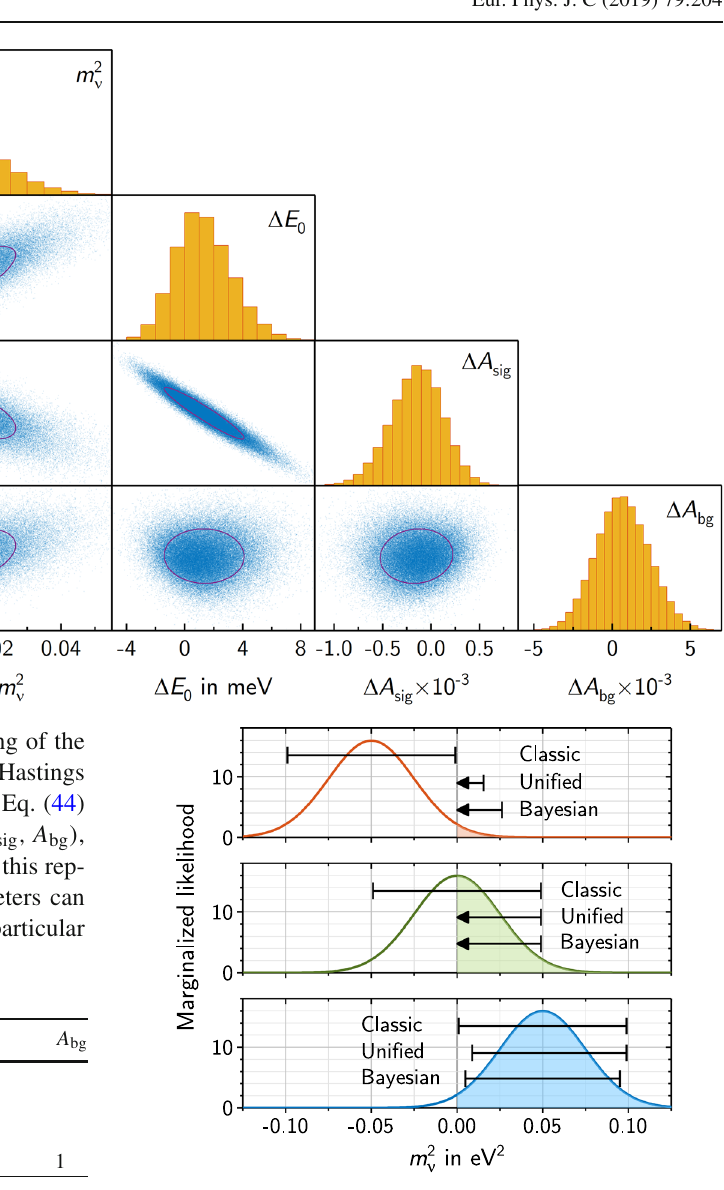
Fig. 17 Marginalized likelihood functions for various estimates of m 2 ν from representative Asimov data sets(In a representative Asimov data set [61] statistical fluctuations are suppressed, effectively replacing the number of (generated) observed events N obs by their expectation value jk (cid:22) (cid:22) N pre m 2 ν = − 0 . 05 eV 2 . Middle panel: m 2 ν = 0 . 0 eV 2 . .). Top panel: jk (cid:22) m 2 ν = 0 . 05 eV 2 ( (cid:22) m ν = 225 meV). The horizontal bars Bottom panel: indicate 95 %C.L.Frequentist central confidence intervals ( Classic ), FeldmanandCousins ( Unified ) respectingthe physicalboundary m 2 ν ≥ 0 eV 2 , and Bayesian credibility intervals ( Bayesian ) with a flat prior for m 2 ν ≥ 0 eV 2 . In the non-physical region the likelihood is calculated relying on Eq.